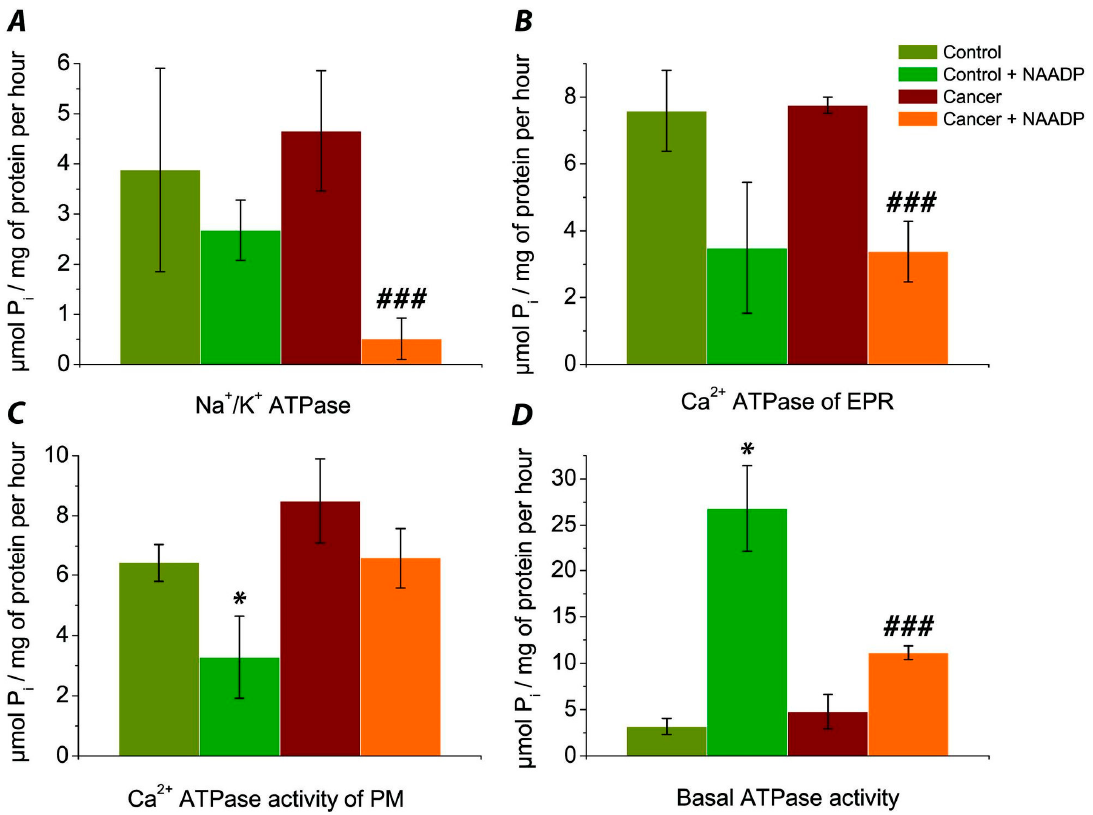
Figure 1. Comparison of NAADP effect on ATPase activity ( µ mol P i /mg of protein per hour) in colorectal mucosa samples from healthy area of patients’ mucosa (control) and the samples of colorectal tumor’s area of the same patients (cancer): Na + /K + ATPase activities, n = 5 pts. (5 samples of control vs. 5 cancer samples) ( A ); Ca 2+ ATPase of EPR, n = 5 pts. (5 samples of control vs. 5 cancer samples) ( B ); Ca 2+ ATPase activity of PM, n = 5 pts. (4 samples of control vs. 5 cancer samples) ( C ); Basal ATPase activity, n = 5 pts. (5 samples of control vs. 5 cancer samples) ( D ). * indicates p < 0.05 (vs. control); ### is p < 0.01 (vs. cancer). The data are expressed as mean ± standard error of the mean.